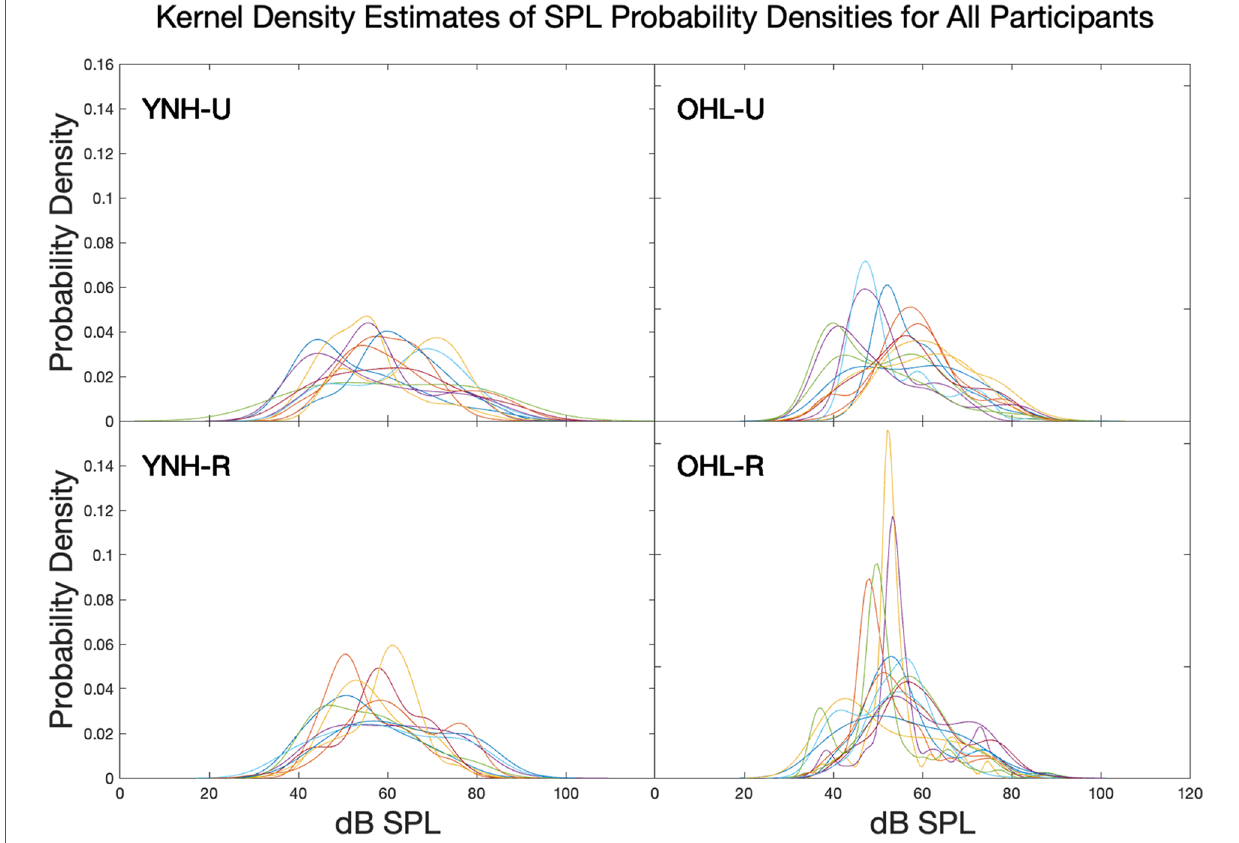
FIGURE 1 Probability density estimates for sound pressure level for each participant in each group. Broader, fl atter probability densities (less predictability) result in higher entropy